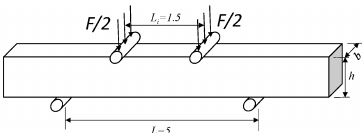
Figure 3. Scheme of four-point bending